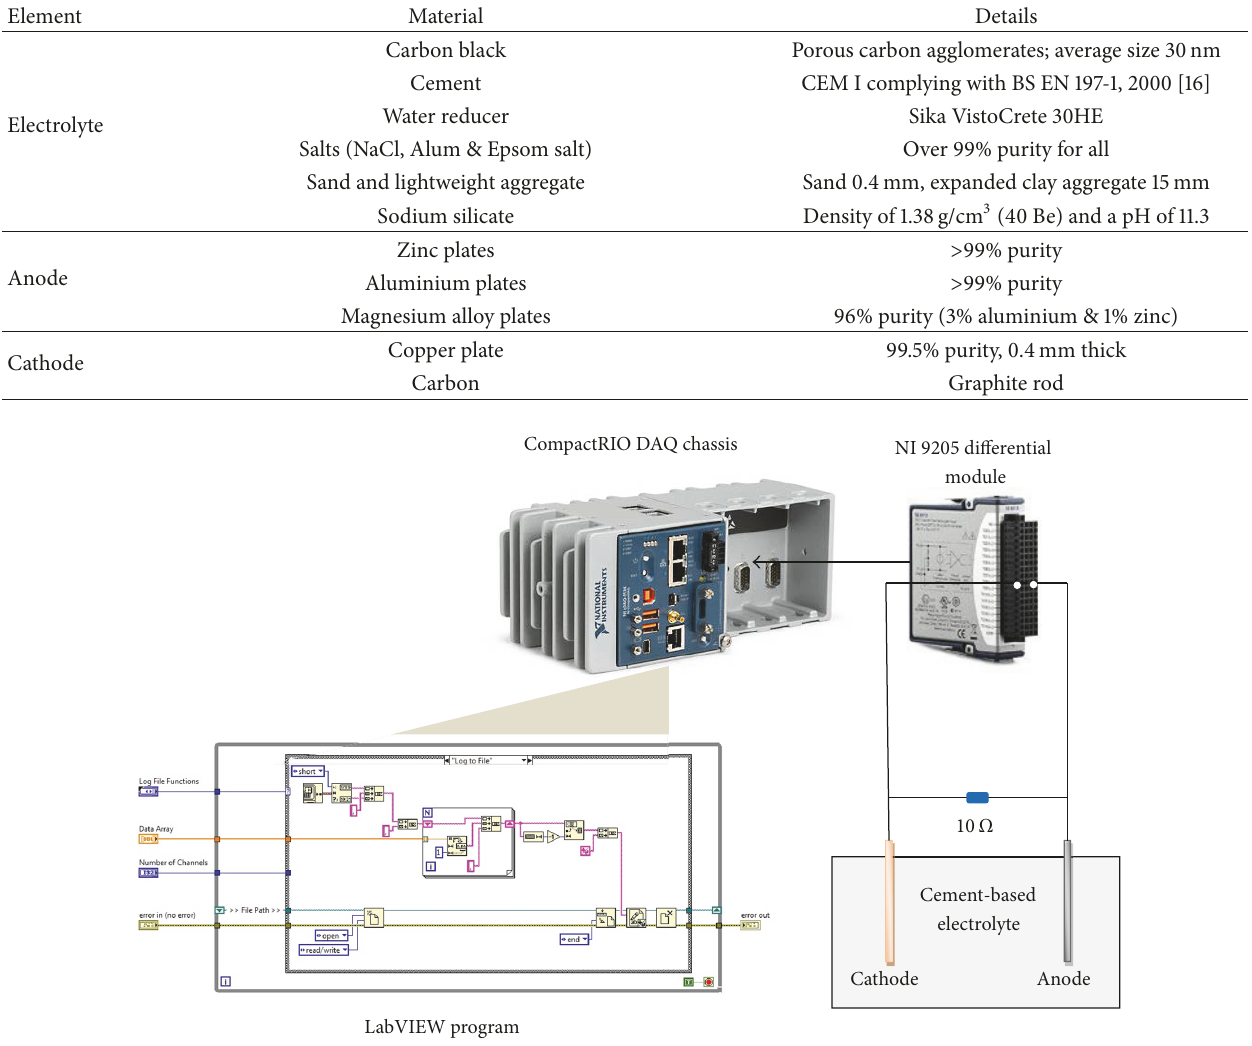
Table 2: Details of cement battery materials.